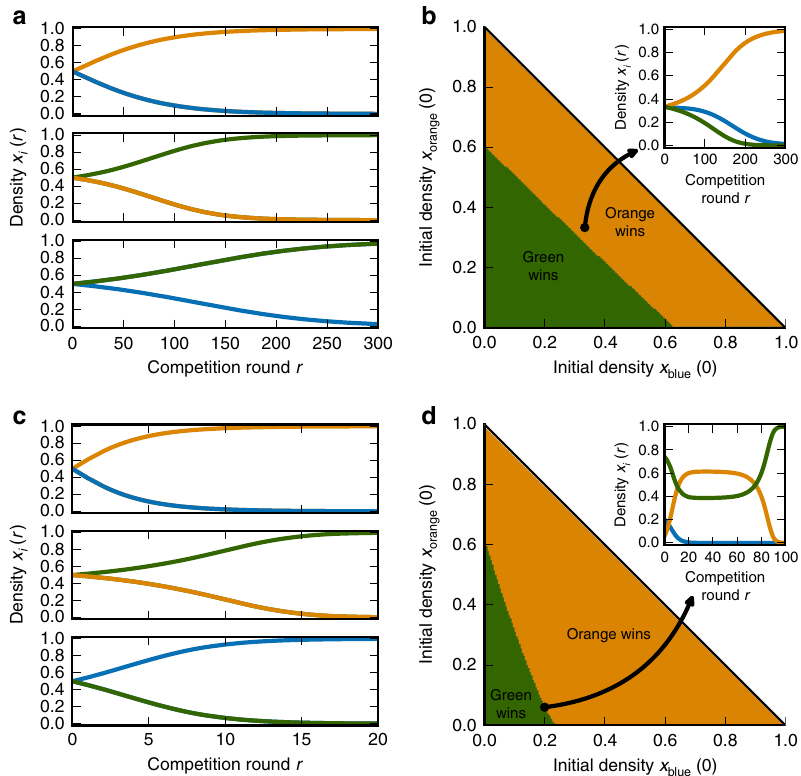
Fig. 4 Pairwise competitions do not predict community behavior. a , b Example of three strains (blue, orange, green) with a single pairwise champion (green). Panel a shows density dynamics x i ( r ) for pairwise competitions, while b shows outcome of mixed competition as a function of initial conditions: orange marks space of initial densities where the orange strain eventually wins, while green marks initial densities where green eventually wins. Inset: density dynamics starting from equal initial densities (marked by black dot in main panel). c , d Same as a , b , but for three strains without a pairwise champion (non-transitivity). See Supplementary Note 8 for parameter